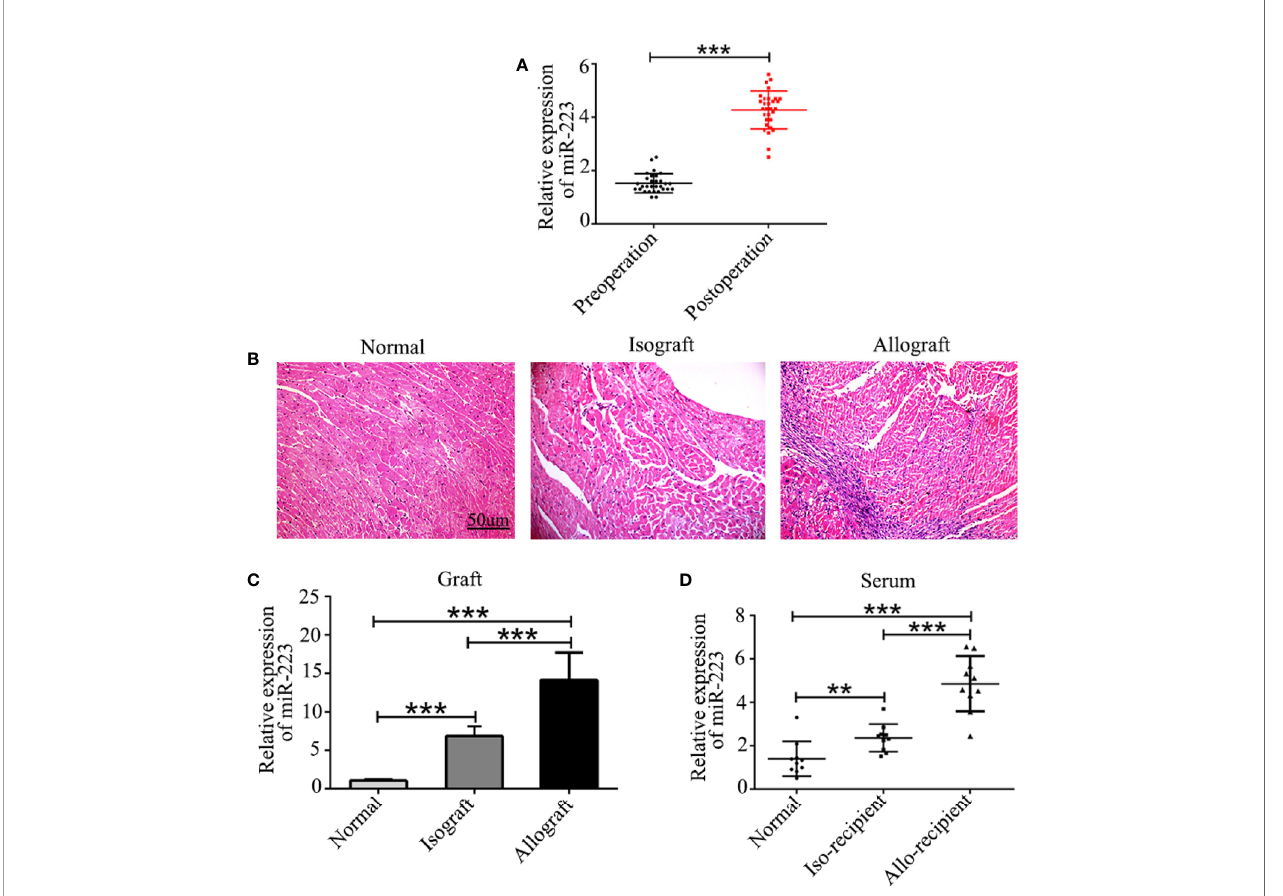
FIGURE 1 | Expression of miR-223 in heart transplant patients and mice. (A) Concentration of miR-223 in the serum of patients before and 7 after days heart transplantation. (B) Pathological structure of normal heart isografts and allografts indicated by H&E staining. (C, D) Expression of miR-223 in heart grafts (C) and serum (D) of mice 7 days after heart transplantation. Data are presented as mean ± SD and represent six experiments. **P < 0.01, ***P <